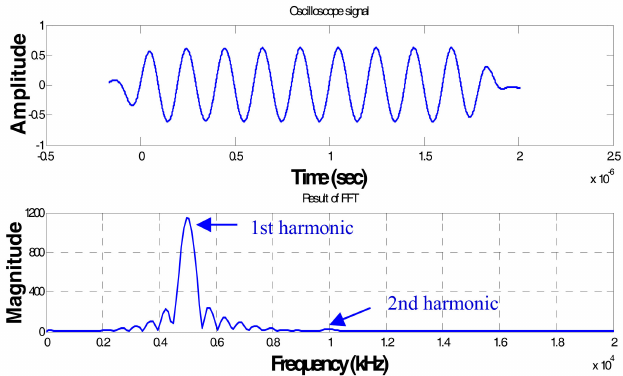
Figure 9. Ultrasonic signal wave and its spectral waveform for the specimen subjected to 1.7% strain amplitude. The signal-processed FFT waveform shows a weak second-order harmonic wave in addition to a strong first-order harmonic wave.